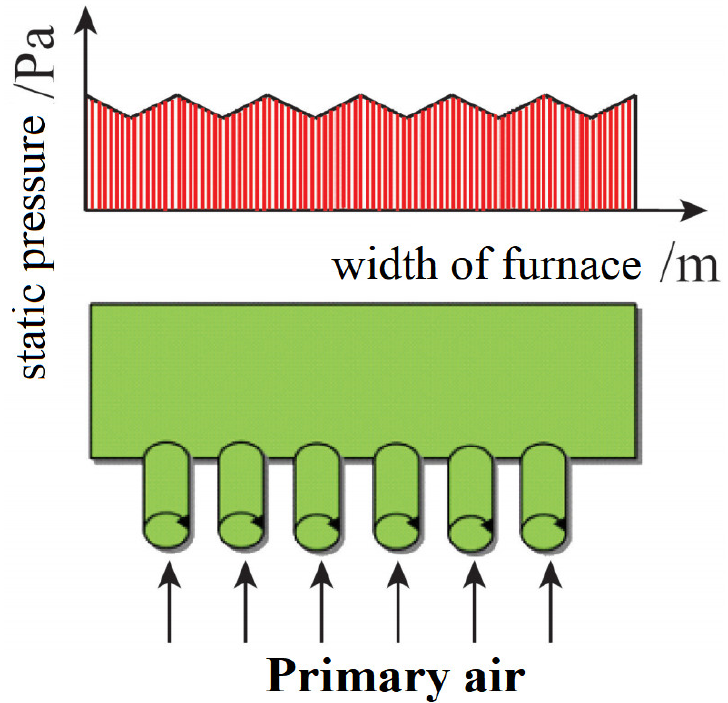
Figure 3. Static pressure distribution of the wind chamber with feeding multiple wind.